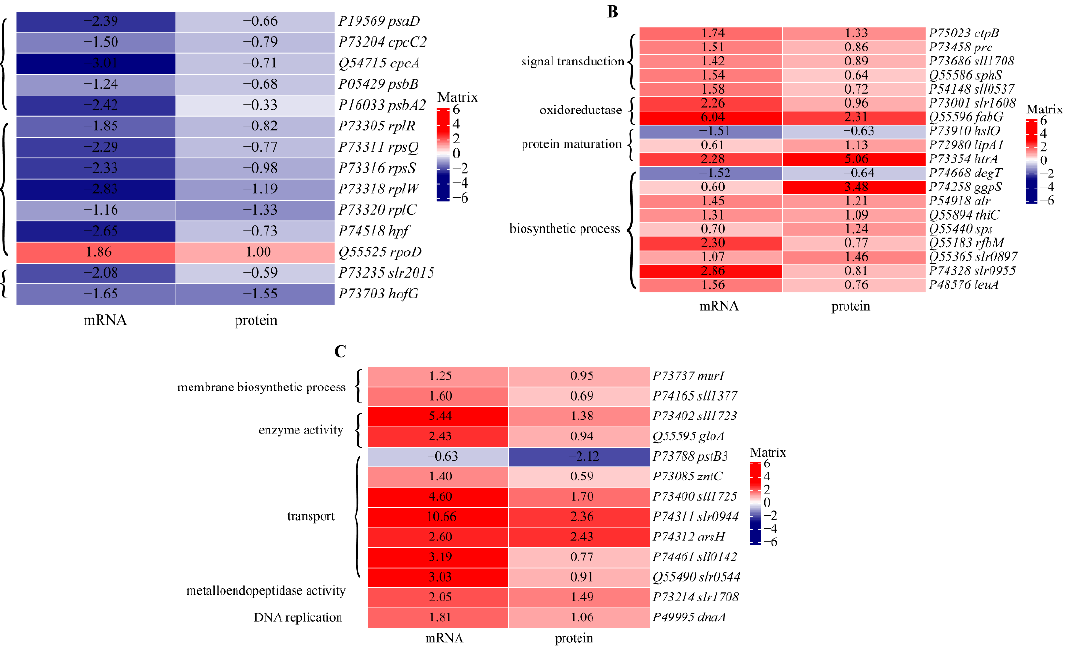
Figure 8. Heat map of differentially expressed genes and protein abundance with consistent expres- sion. ( A ) GO clustering in photosynthesis, translation, and mobility. ( B ) GO clustering in signal transduction, oxidoreductase, protein maturation, and biosynthetic process. ( C ) GO clustering in membrane biosynthetic process, enzyme activity, transport, metalloendopeptidase activity, and DNA replication.